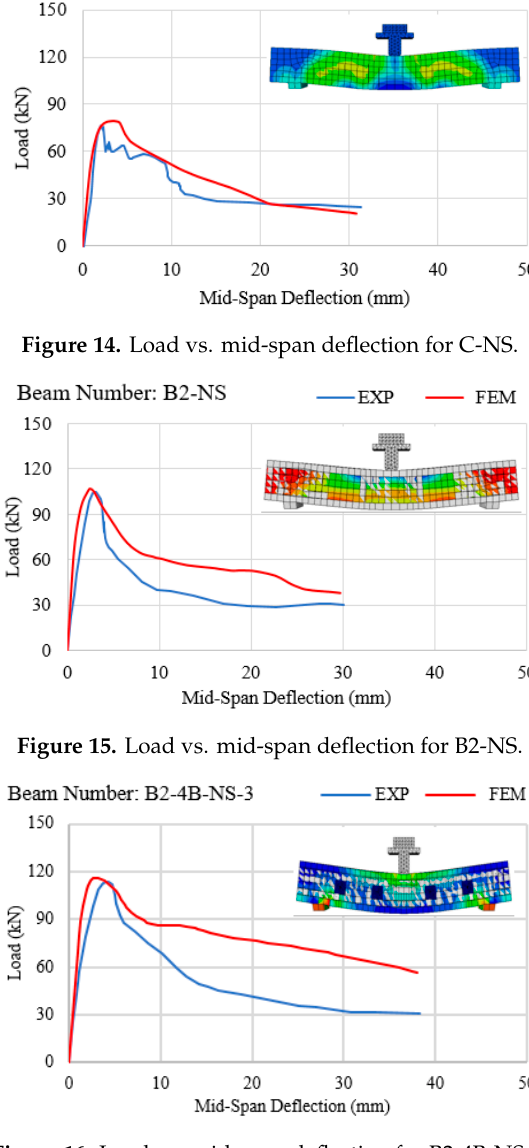
Figure 16. Load vs. mid-span deflection for B2-4B-NS-3.